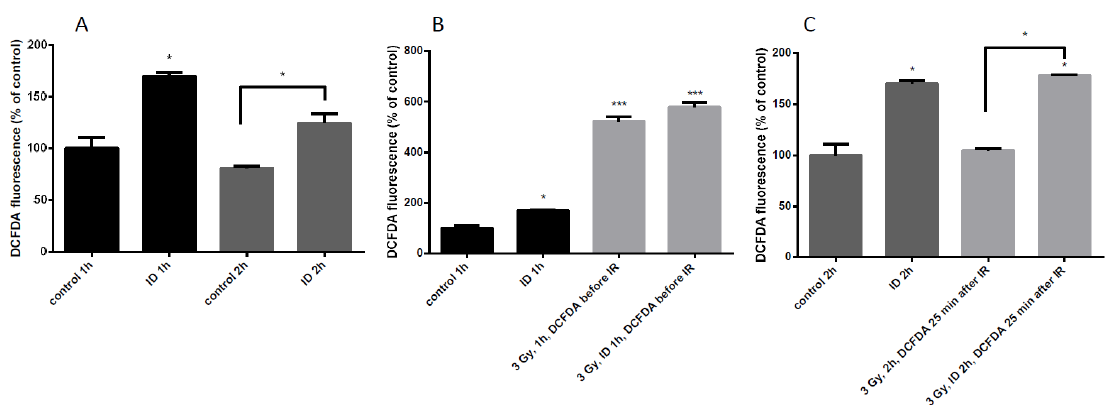
Figure 6. ID and radiation differentially increase ROS cellular content in MCF12A cells. Cells were cultured in iodine-containing medium for 7 days. Thereafter, the medium was replaced by iodine-containing (control) or iodine deficient (ID) medium and cells were irradiated with a dose of 3 Gy. Cells were harvested 1 ( A (two first columns), B ) or 2 h (A (two last columns), and C ) after medium change. Cellular reactive oxygen species (ROS) content was visualized with DCF-DA and measured by flow cytometry. In irradiated cells, DCF-DA was added 10 min before exposure to radiation (B) or 25 min after the irradiation (C). DCF-DA was added at corresponding timing in non-irradiated cells. Data are expressed as means ± SEM. p -values < 0.05 were considered as statistically significant. * p < 0.05, *** p < 0.001. Statistical test: one-way ANOVA with Tukey post-hoc test. N = 3, one representative experiment.